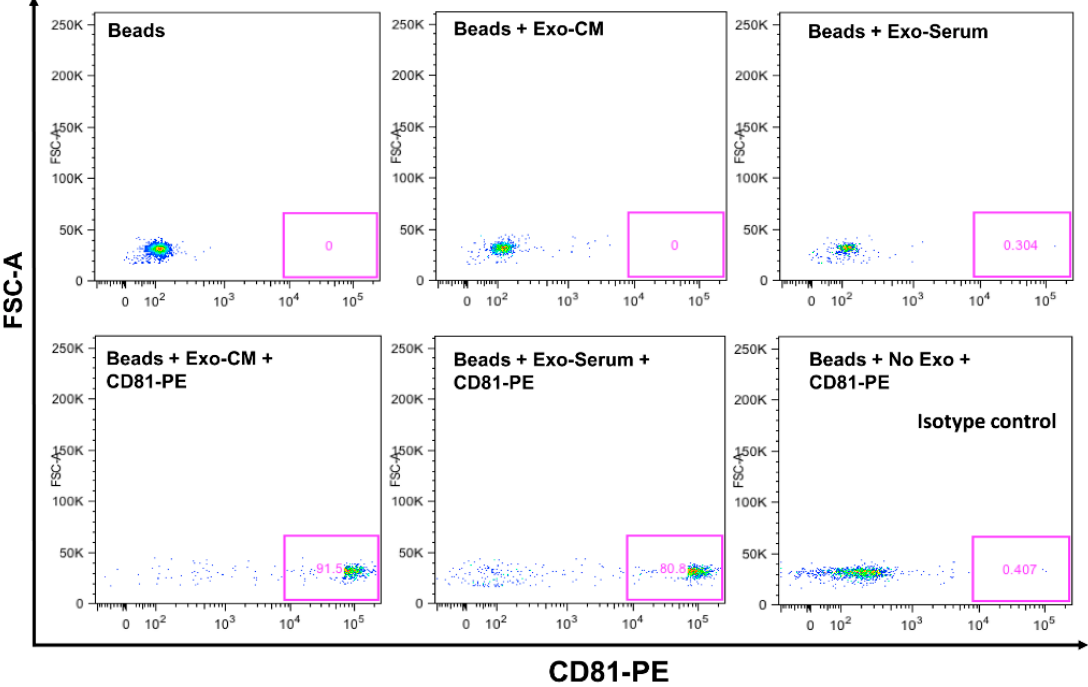
Figure 1. Expression of CD63 and CD81 on exosomes by flow cytometer. Binding / capture of exosomes was carried out with CD63 antibody coated magnetic beads overnight at room temperature. Bead captured exosomes were stained with primary antibody CD81 antibody (Biotin conjugated), then stained with secondary detection reagent (streptavidin-PE conjugated). Each condition was labeled for control purpose in the figure. Exo-serum represents, exosomes derived from serum. Exo-CM represents, exosomes derived from conditioned medium of JM1 cell.